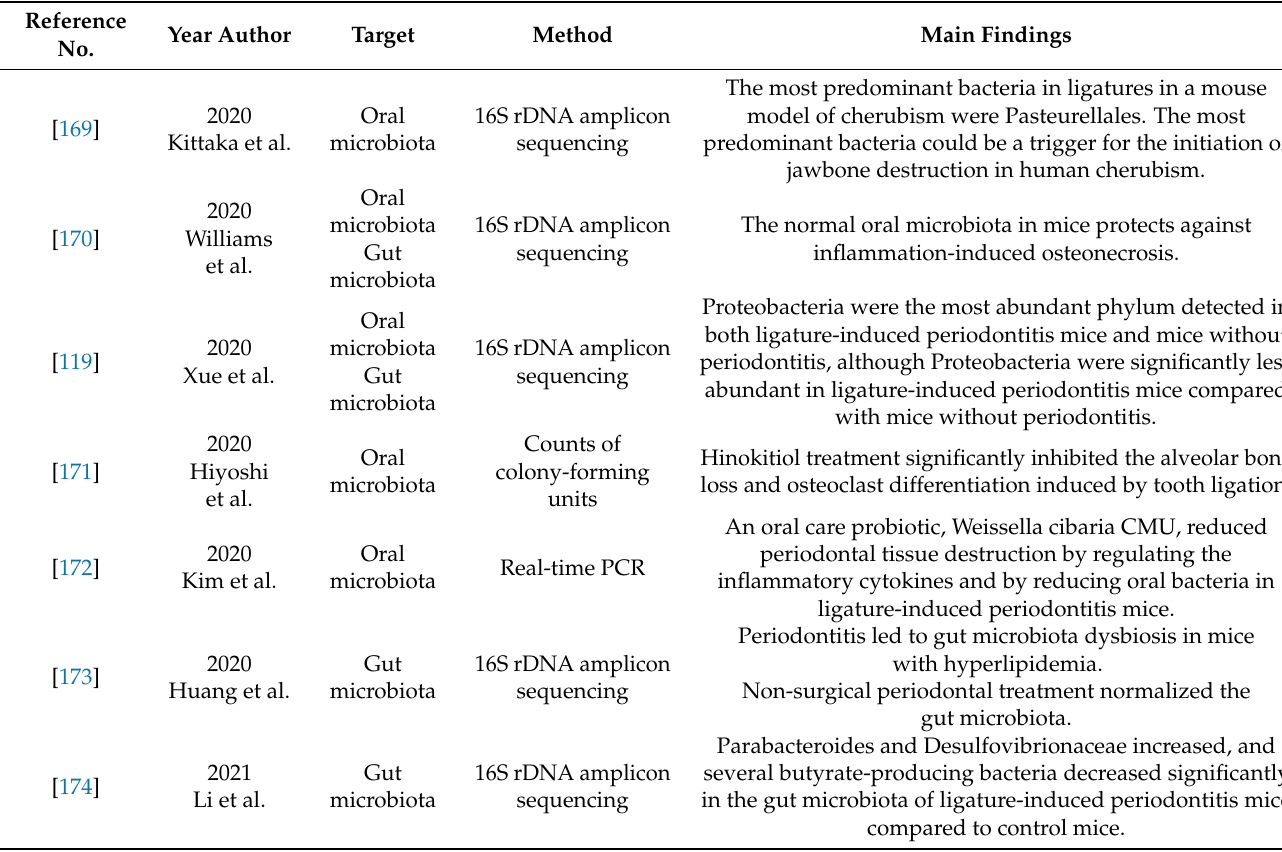
Table 7. Summary of oral and gut microbiota of ligature-induced periodontitis